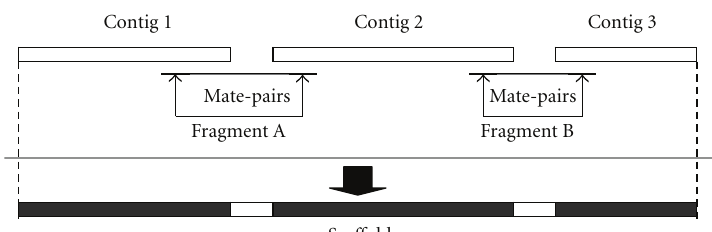
Figure 1: Formation of contigs.